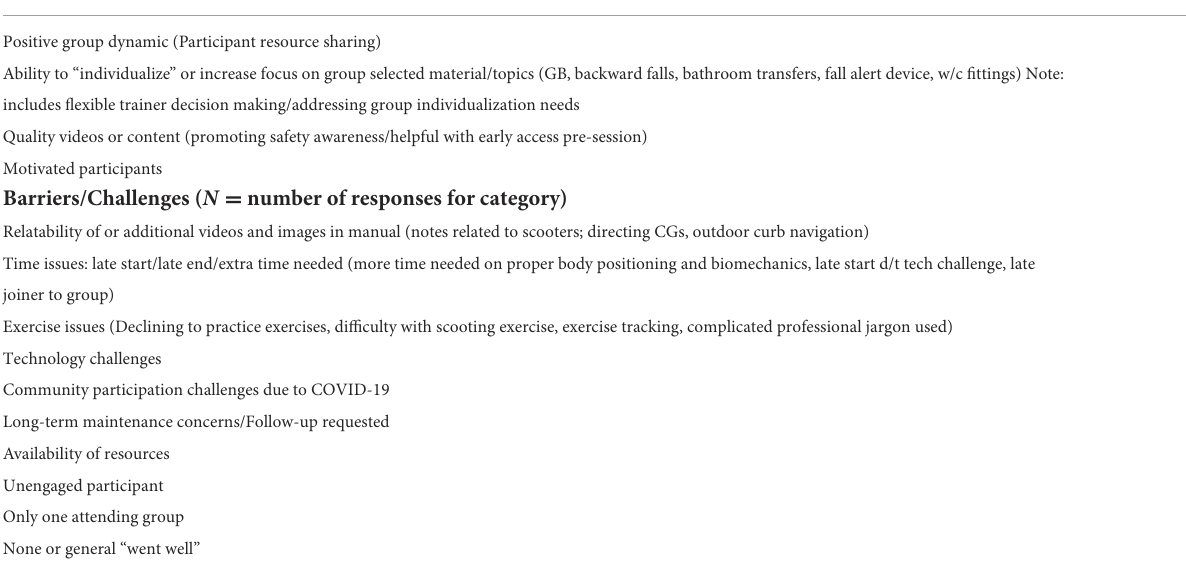
TABLE 8 Summary of iROLL-O’s Trainer Fidelity Form open ended coding. Facilitators/Positives ( N = number of responses for category) Positive group dynamic (Participant resource